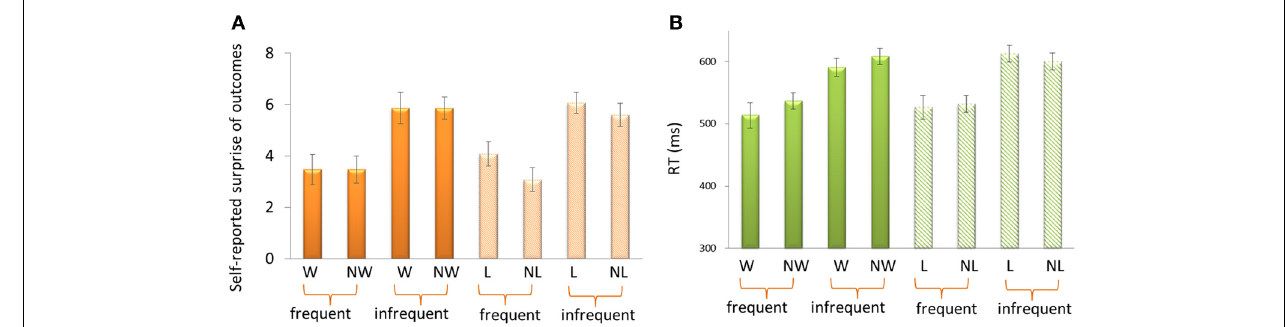
FIGURE 2 | Self-reported surprise (A) and reaction times (B) in response to outcomes. W, win; NW, no win; L, loss; NL, no